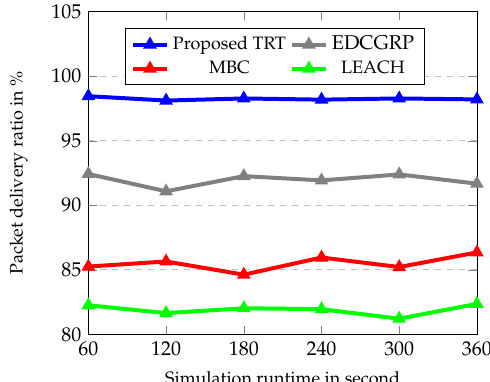
Figure 7. Packet Delivery Ratio vs. Simulation